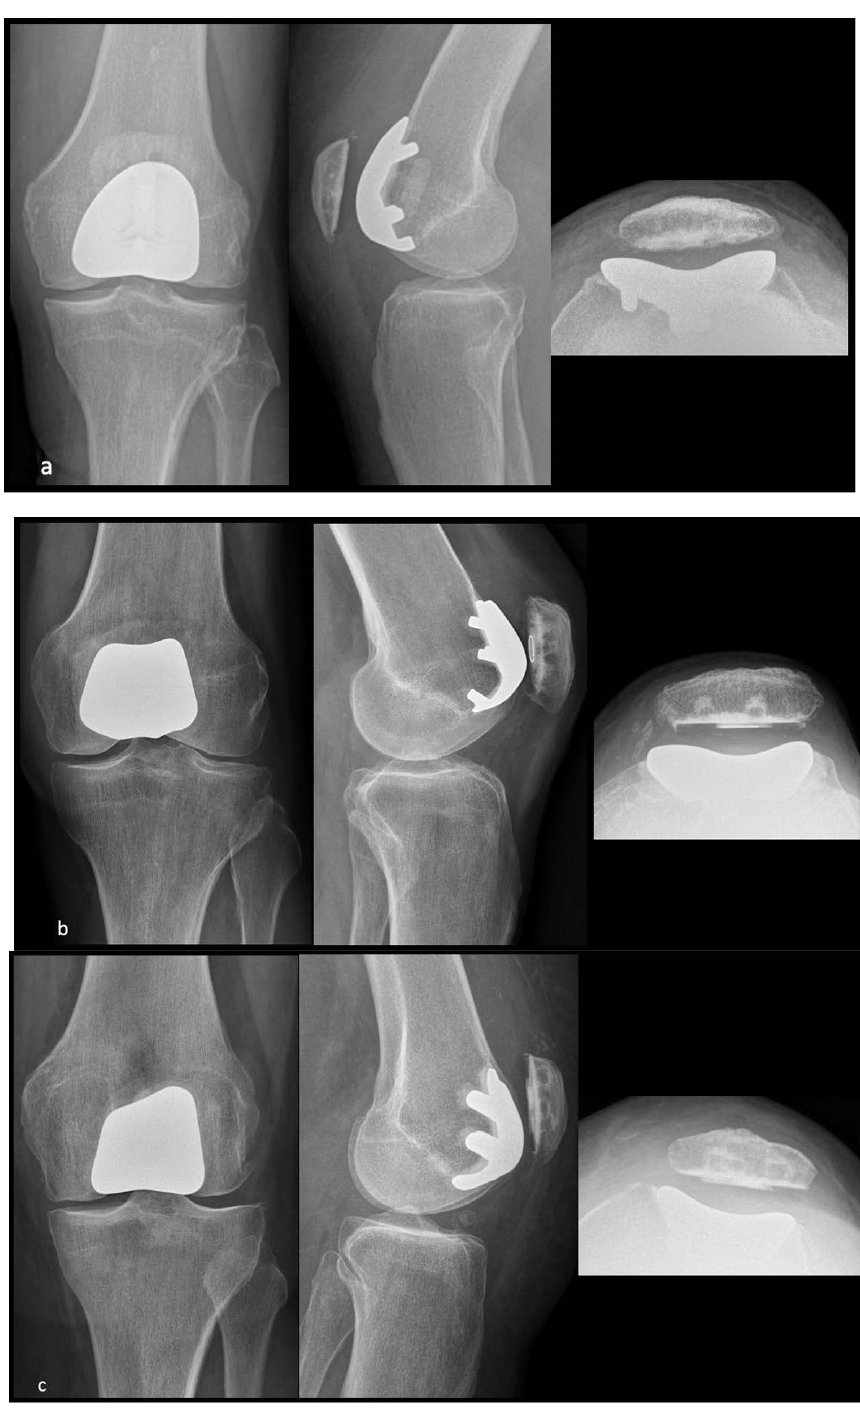
Figure 1. Postoperative radiographs of PFA performed conventionally (onlay implant) ( a ), with an image-free robotic system (onlay implant) ( b ) and with an image-based robotic system (inlay implant) ( c ). Table 1. Demographic data and preoperative radiological parameters.